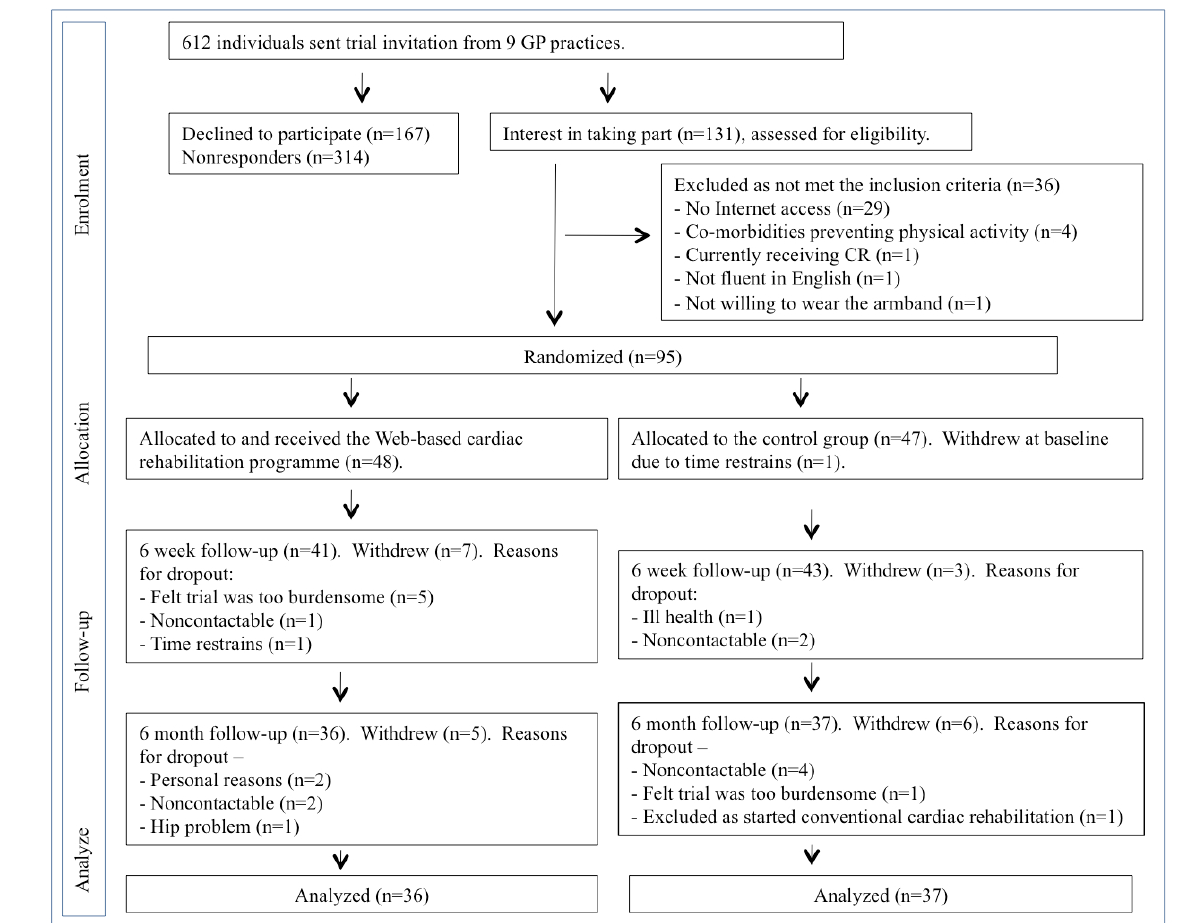
Figure 3. Participant flow through the